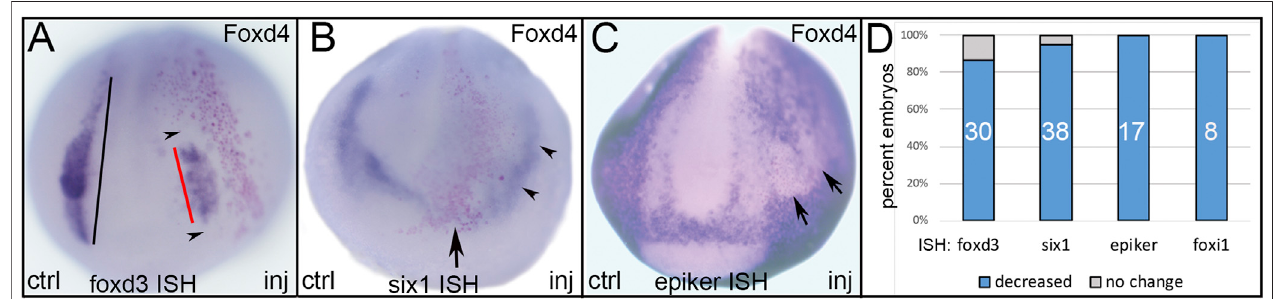
FIGURE 2 | The effects of expressing an NP-enriched transcription factor, Foxd4, in ectopic domains. (A) Ectopic expression of Foxd4 (NP TF) in a neural crest precursor blastomere showed reduced sizeofthe foxd3 neural crestdomain (red bar) onthe injected sideofthe embryo. Compare to thelength ofthe foxd3 expression domainonthecontrolside(blackbar).Notethat foxd3 isreducedbothinareasoccupiedbylineage-labeledcells(reddots)aswellasareasadjacenttothesecells(black arrowheads).ctrl,controlside;inj,injected side,anteriorviewwithdorsaltothetop. (B) Ectopicexpression ofFoxd4(NPTF)attheanteriordorsalmidline(reddots) eliminated six1 expression in the anterior PPR (arrow), and reduced expression in the posterior PPR (black arrowheads) adjacent to the lineage-labeled cells. Anterior view with dorsal to the top. (C) Ectopic expression of Foxd4 (NP TF) in a lateral position (red dots) eliminated the expression of epidermis-speci fi c keratin ( epiker ) in the lateral epidermis (arrows). Anterior view with dorsal to the top. (D) The percentage of embryos in which ectopic Foxd4 reduced expression of neural crest ( foxd3 ), PPR ( six1 ) or epidermis ( epiker , foxi1 ) genes. Numbers within the bars denote sample size.